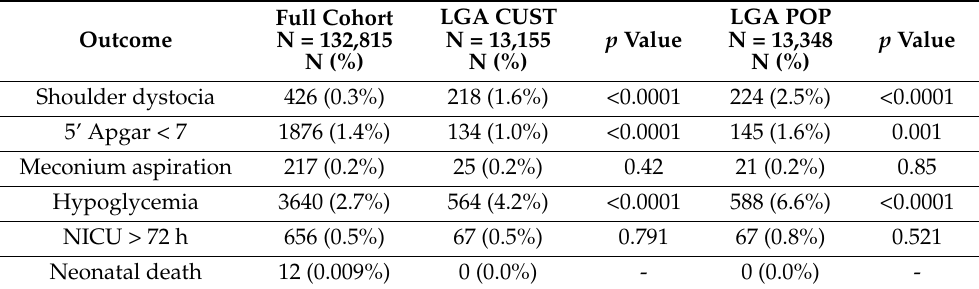
Table A3. Adverse neonatal outcomes by LGA groups.